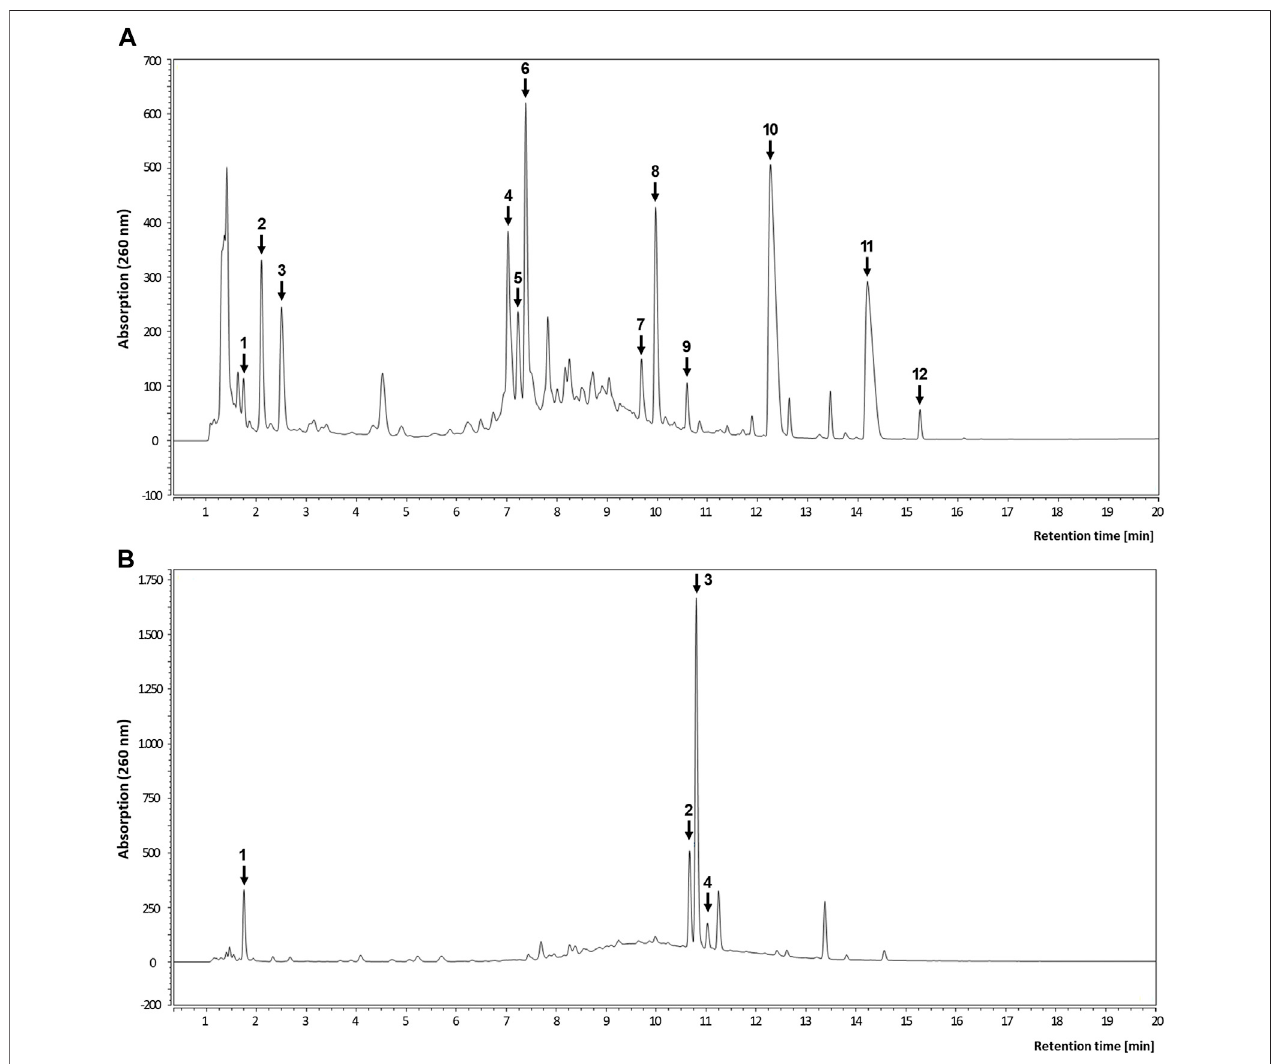
FIGURE 7 | Representative HPLC analyses of root extracts. Chromatogram of avens root extract (A) and roseroot extract (B) recorded at 260 nm. For peak identi fi cation, refer to Table 3 .